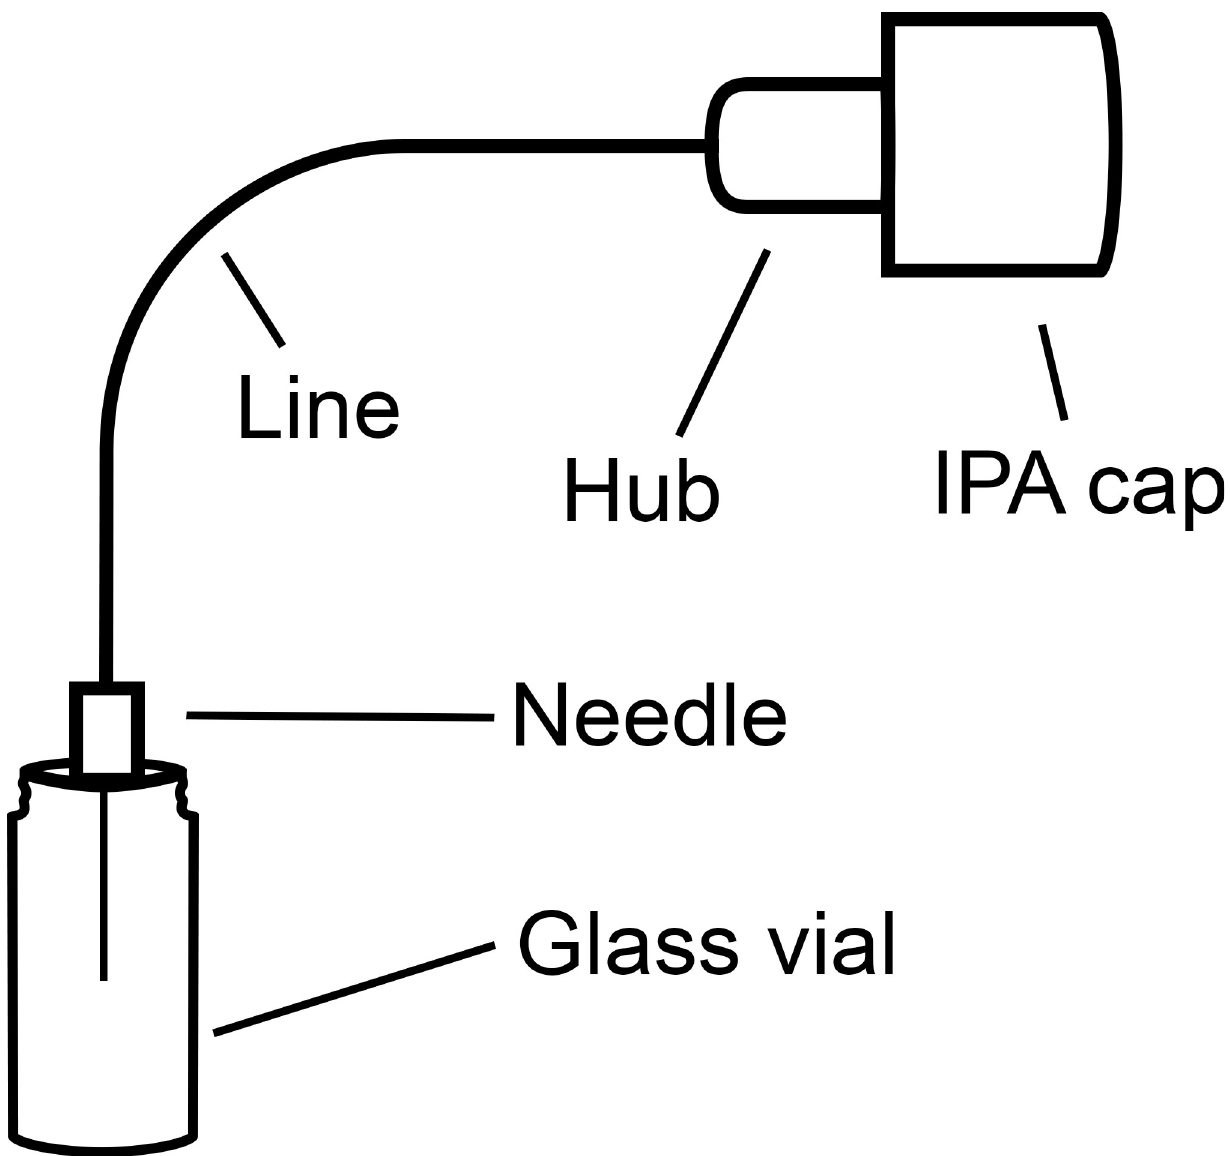
Fig 1. Schematic of IPA cap circuit system.